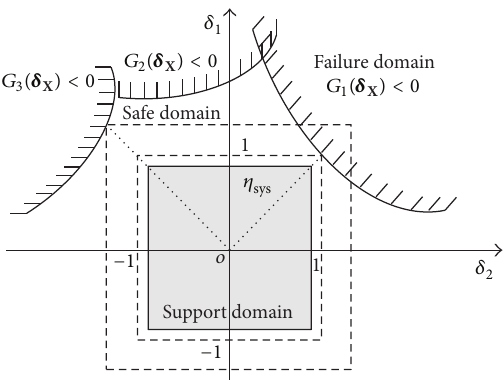
Figure 2: The nonprobabilistic reliability of a structure